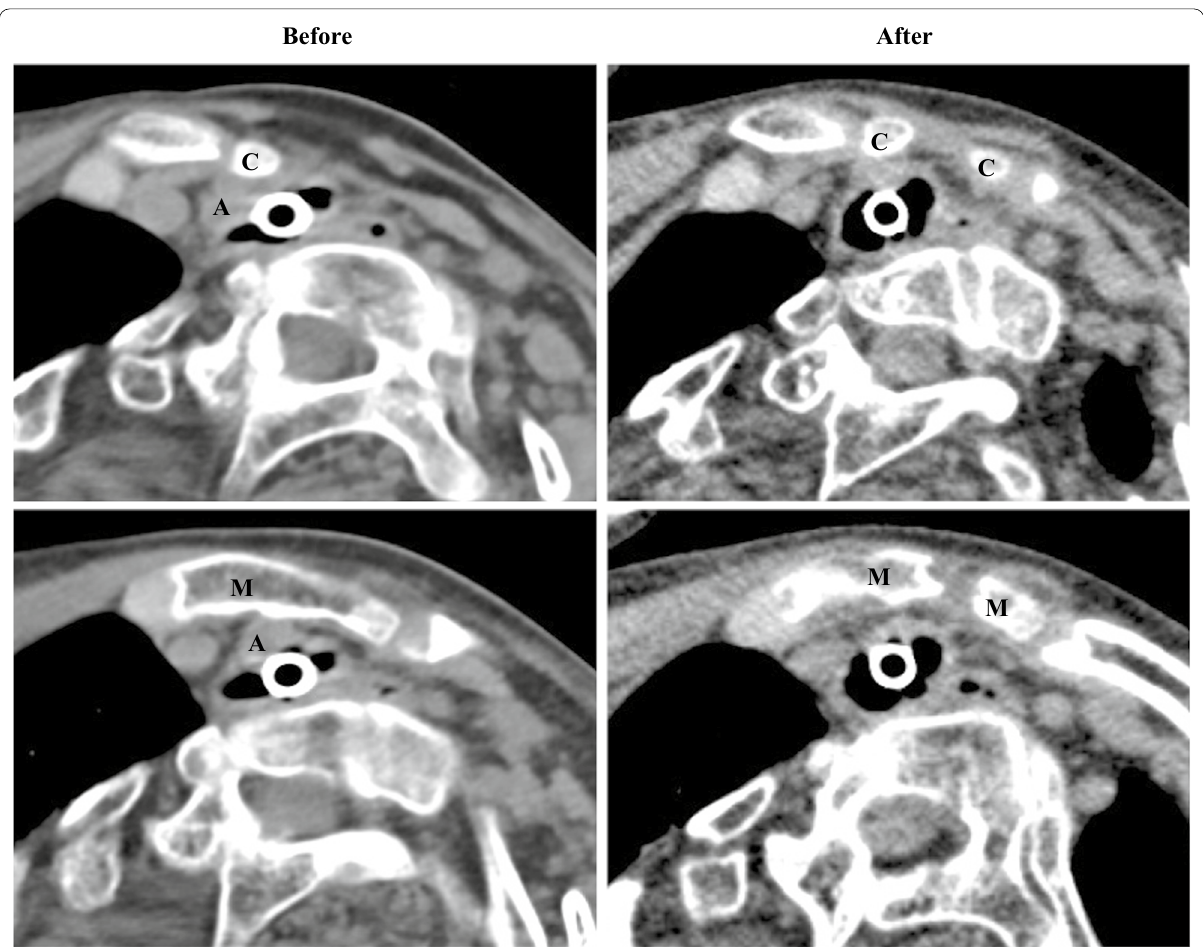
Fig. 3 Computed tomography imaging before and after transection of the brachiocephalic artery and thoracoplasty in Patient 2. A brachiocephalic artery; C sternal end of the clavicle; M manubrium